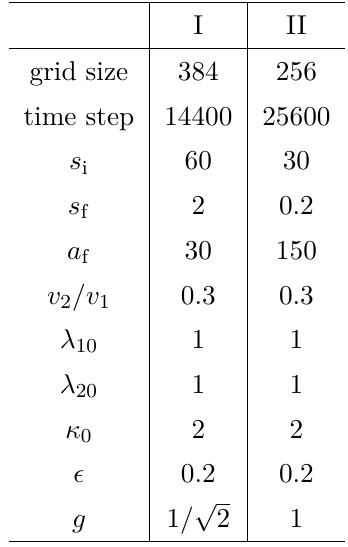
Table 1 . The model parameters for the numerical